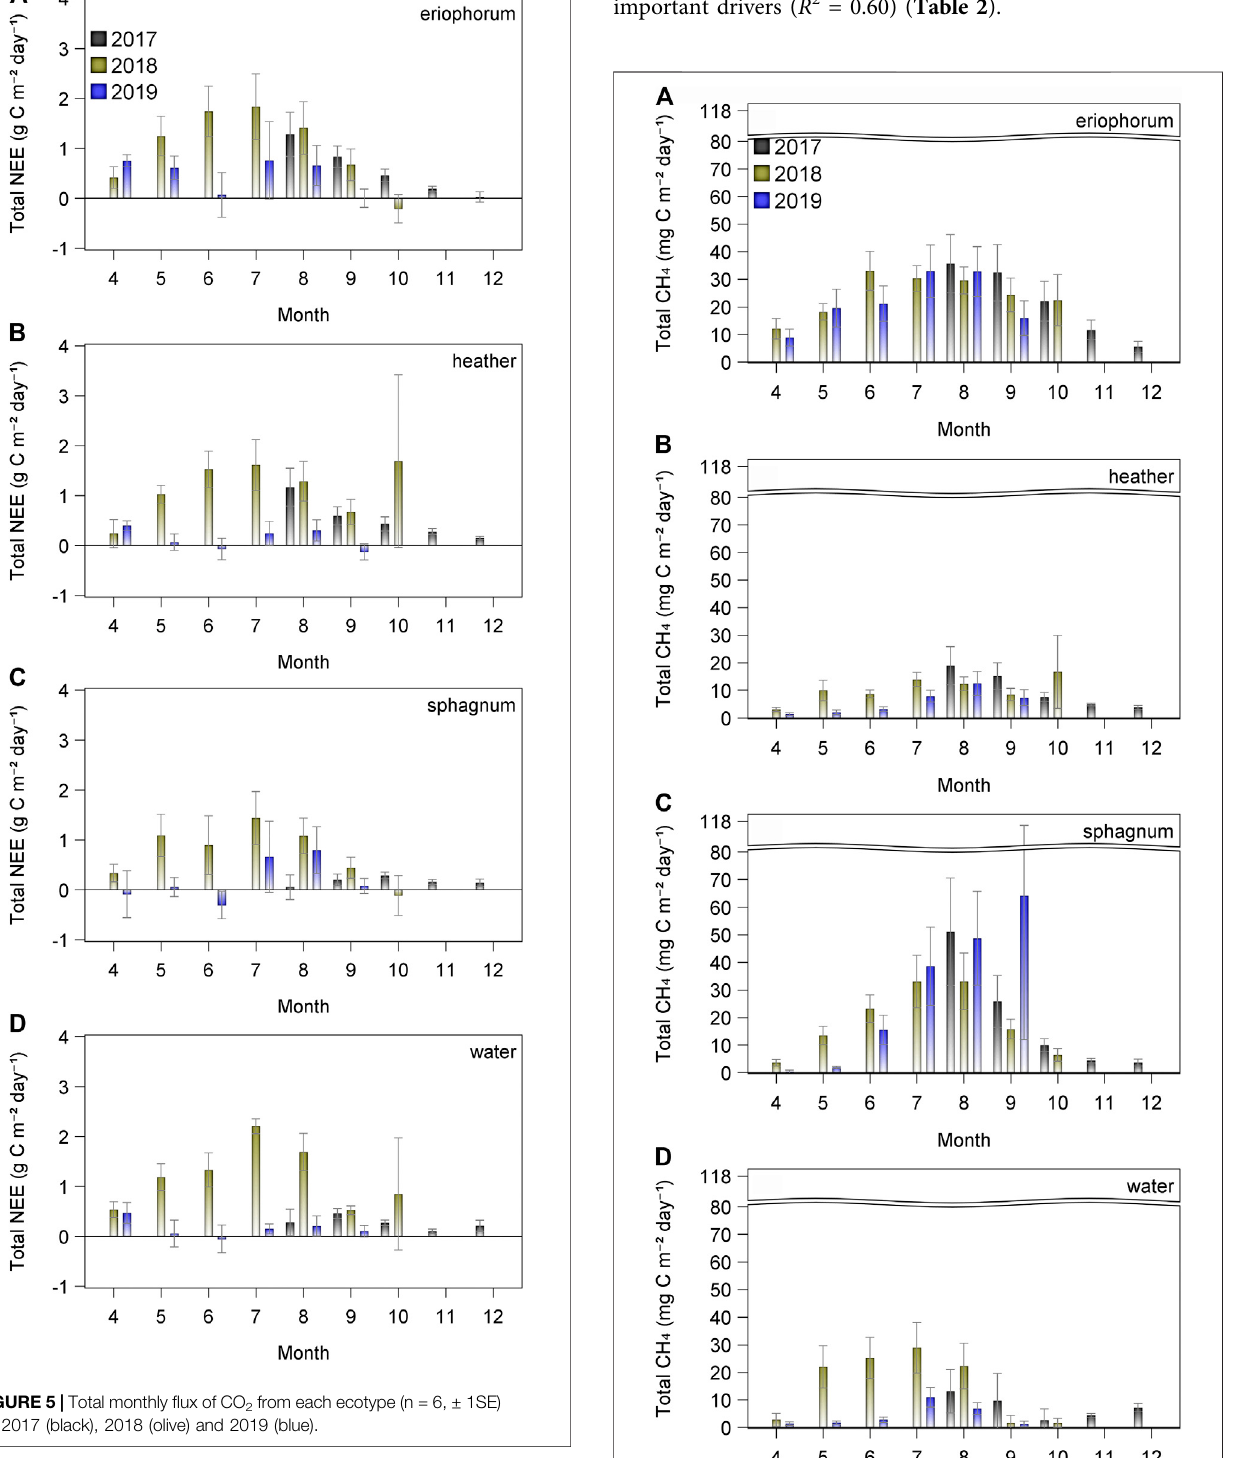
uxes from eriophorum ( R 2 (cid:2) 0.37), heather ( R 2 (cid:2) 0.46) and sphagnum ( R 2 (cid:2) 0.73), but the story was less clear in water, where